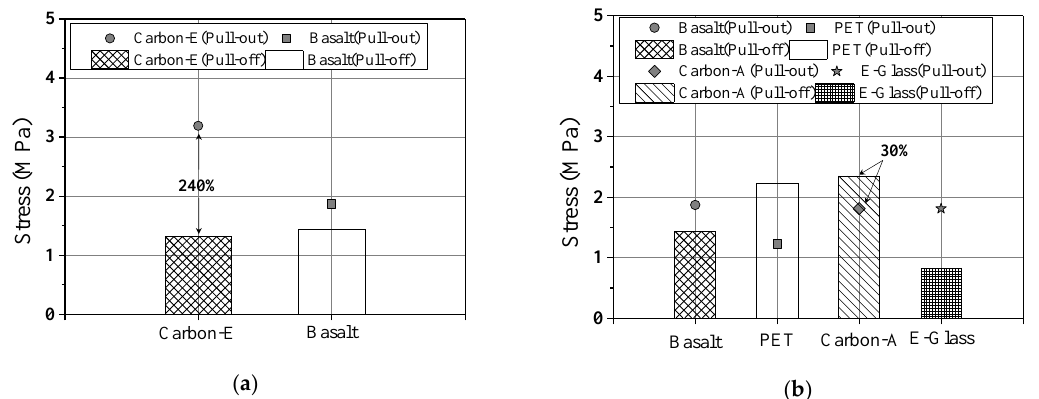
Figure 10. Comparison of bond stress with respect to the test method: ( a ) type of textile; ( b ) type of weaving.